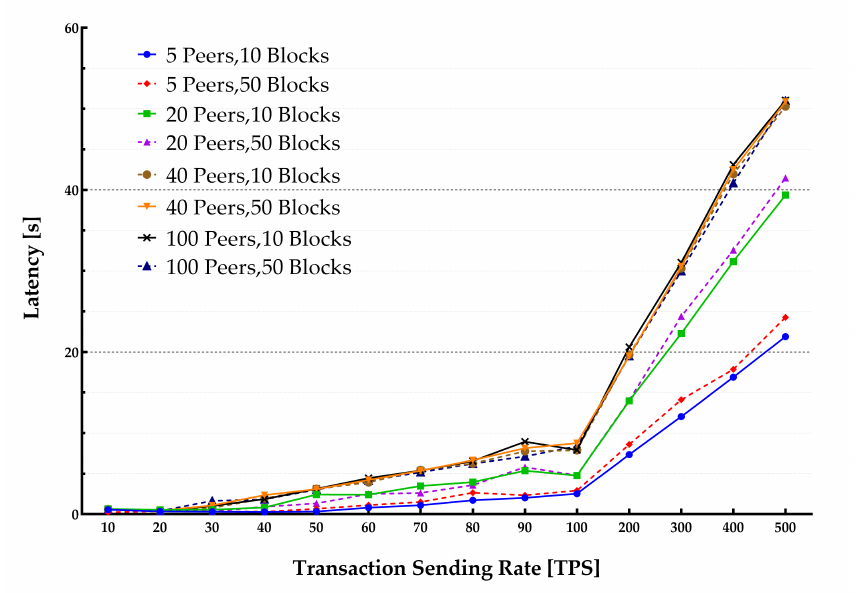
Figure 12. Impact of block sizes on transactions